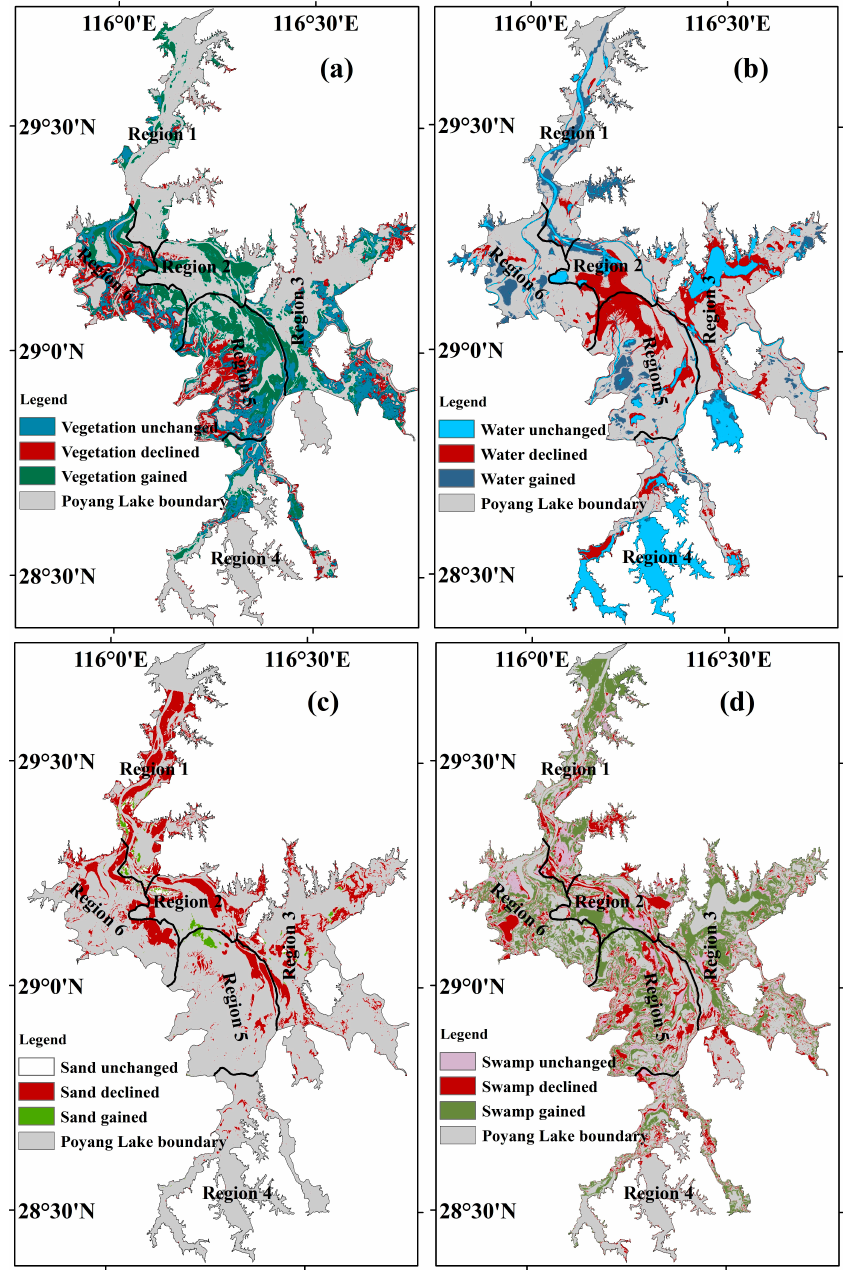
Figure 5. Spatial distribution of ( a ) vegetation, ( b ) water, ( c ) sand, and ( d ) swamp and marsh, and mudflat with unchanged, decreased, and increased areas in Poyang Lake from 1973 to 2019